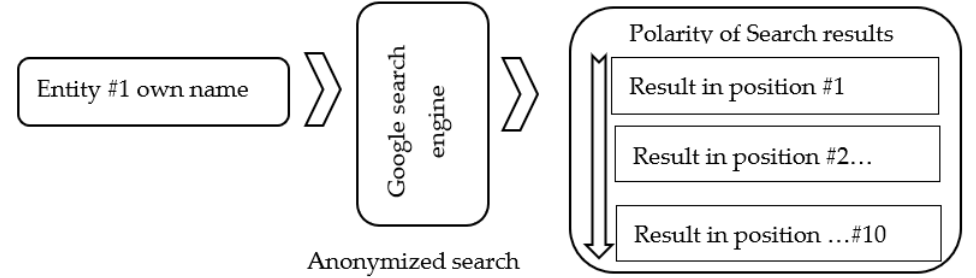
Figure 3. The process of sentiment analysis—one entity.